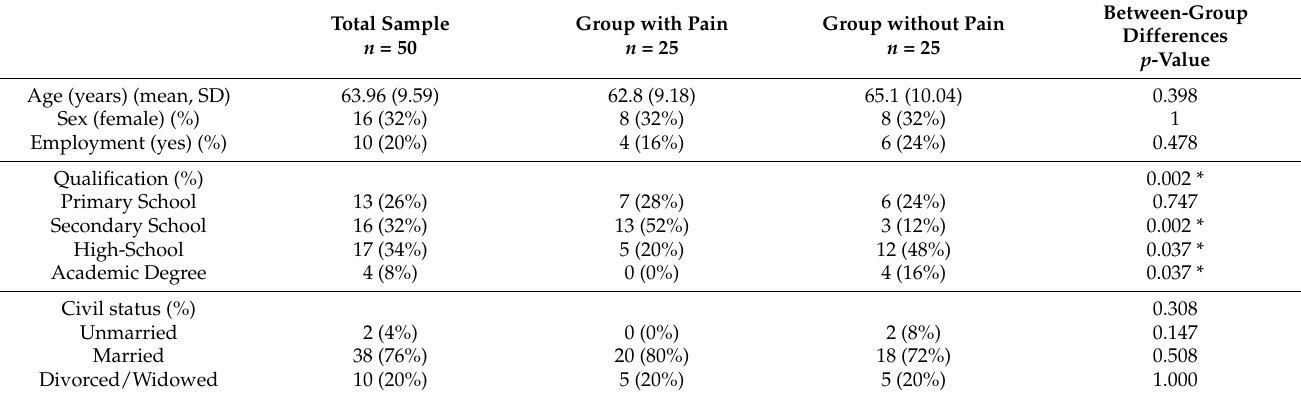
Table 1. Patients sociodemographic and clinical